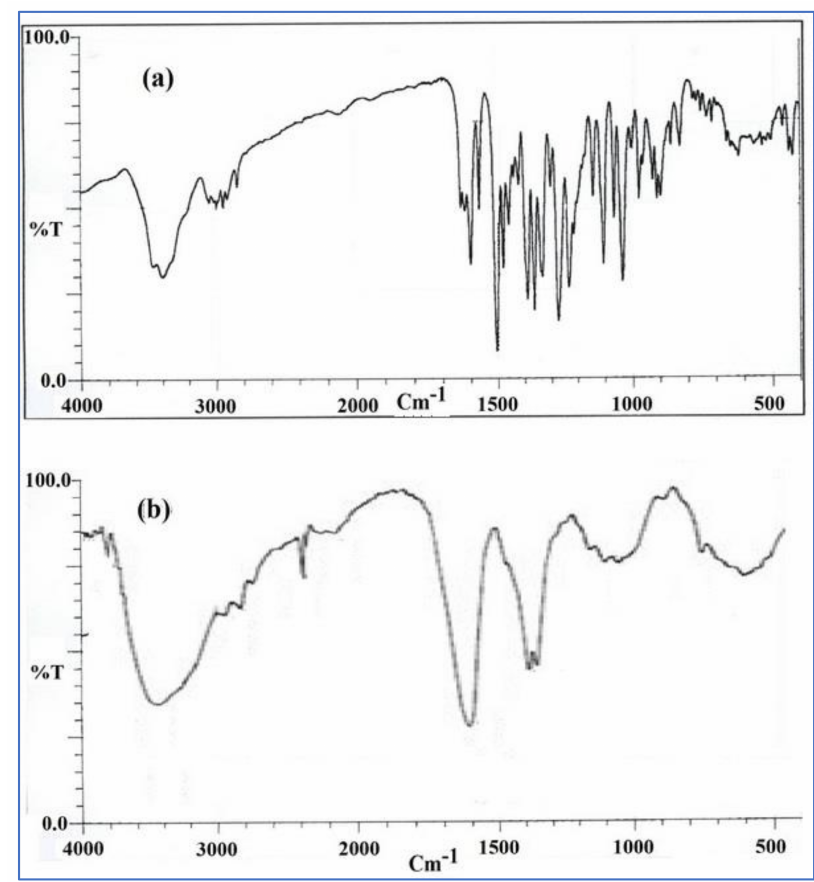
Figure 3. FTIR spectra of ( a ) pure BBR and ( b )